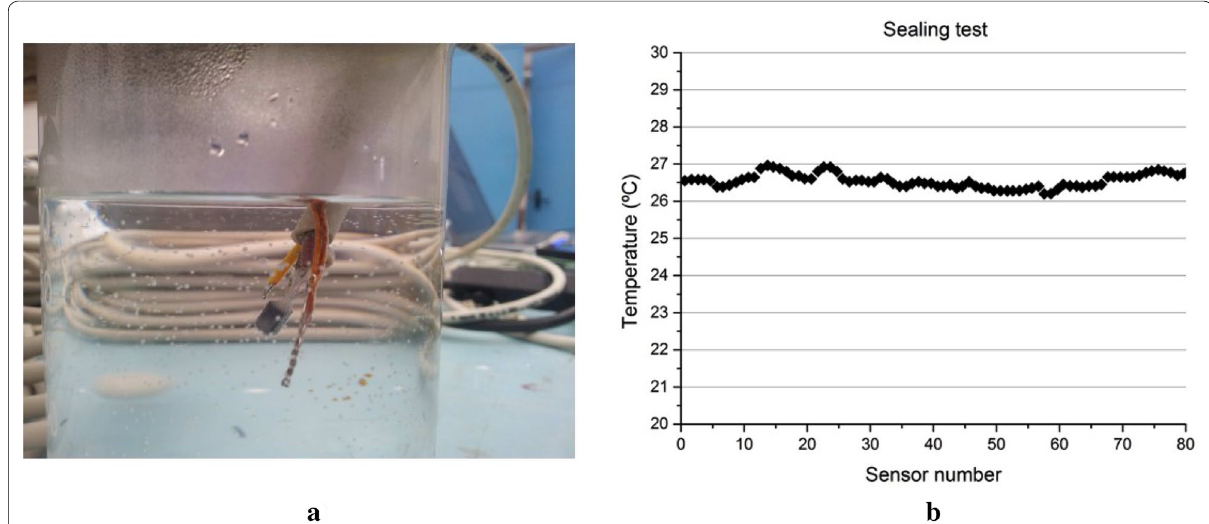
Fig. 1 a Calibration process of the sensor DS18B20: sensor and thermocouples used as reference immersed in water, and b temperature measurement during the sealing tests.